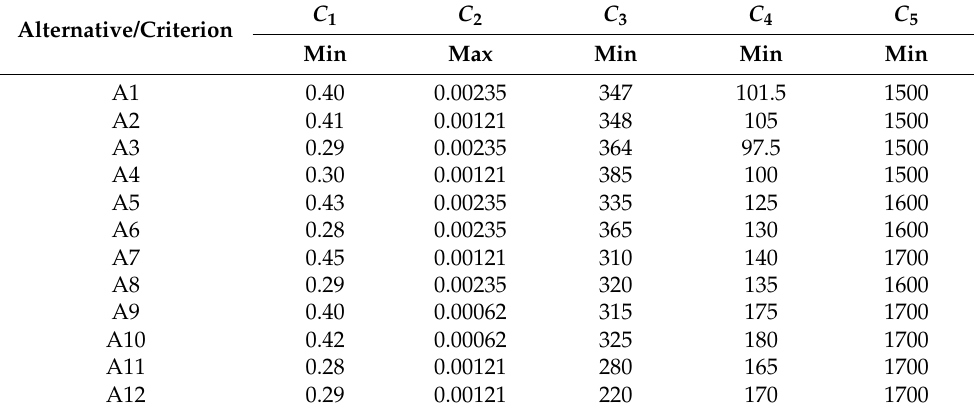
Table 9. Input decision matrix.